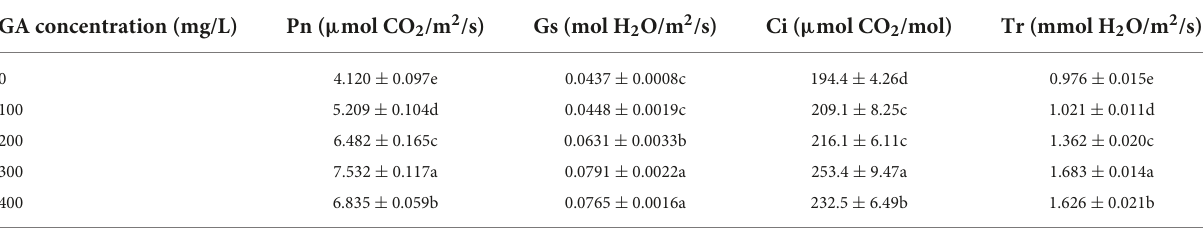
TABLE 1 Photosynthetic characteristic of C . betacea .